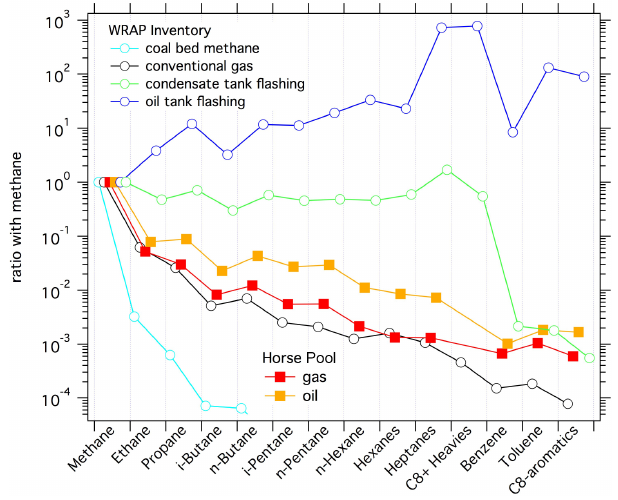
Figure 13. Emission ratios of VOCs with methane from the Horse Pool ground site compared to the WRAP inventory VOC emission composition of the conventional gas, oil and condensate tank flash-